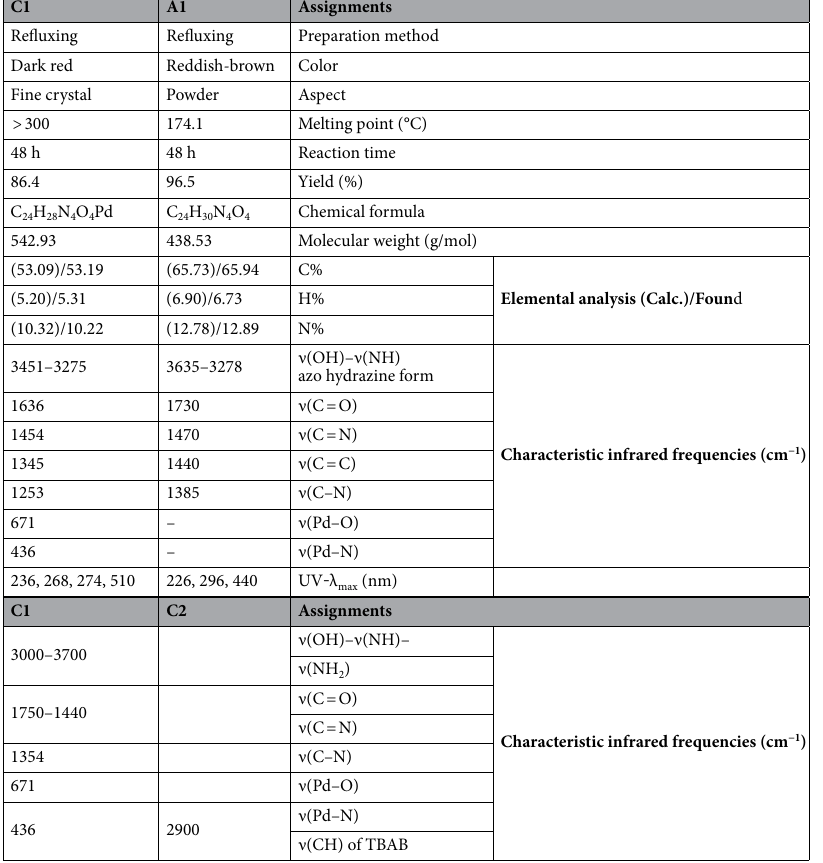
Table 1. Analytical and some important physical measurements for A1, C1 and